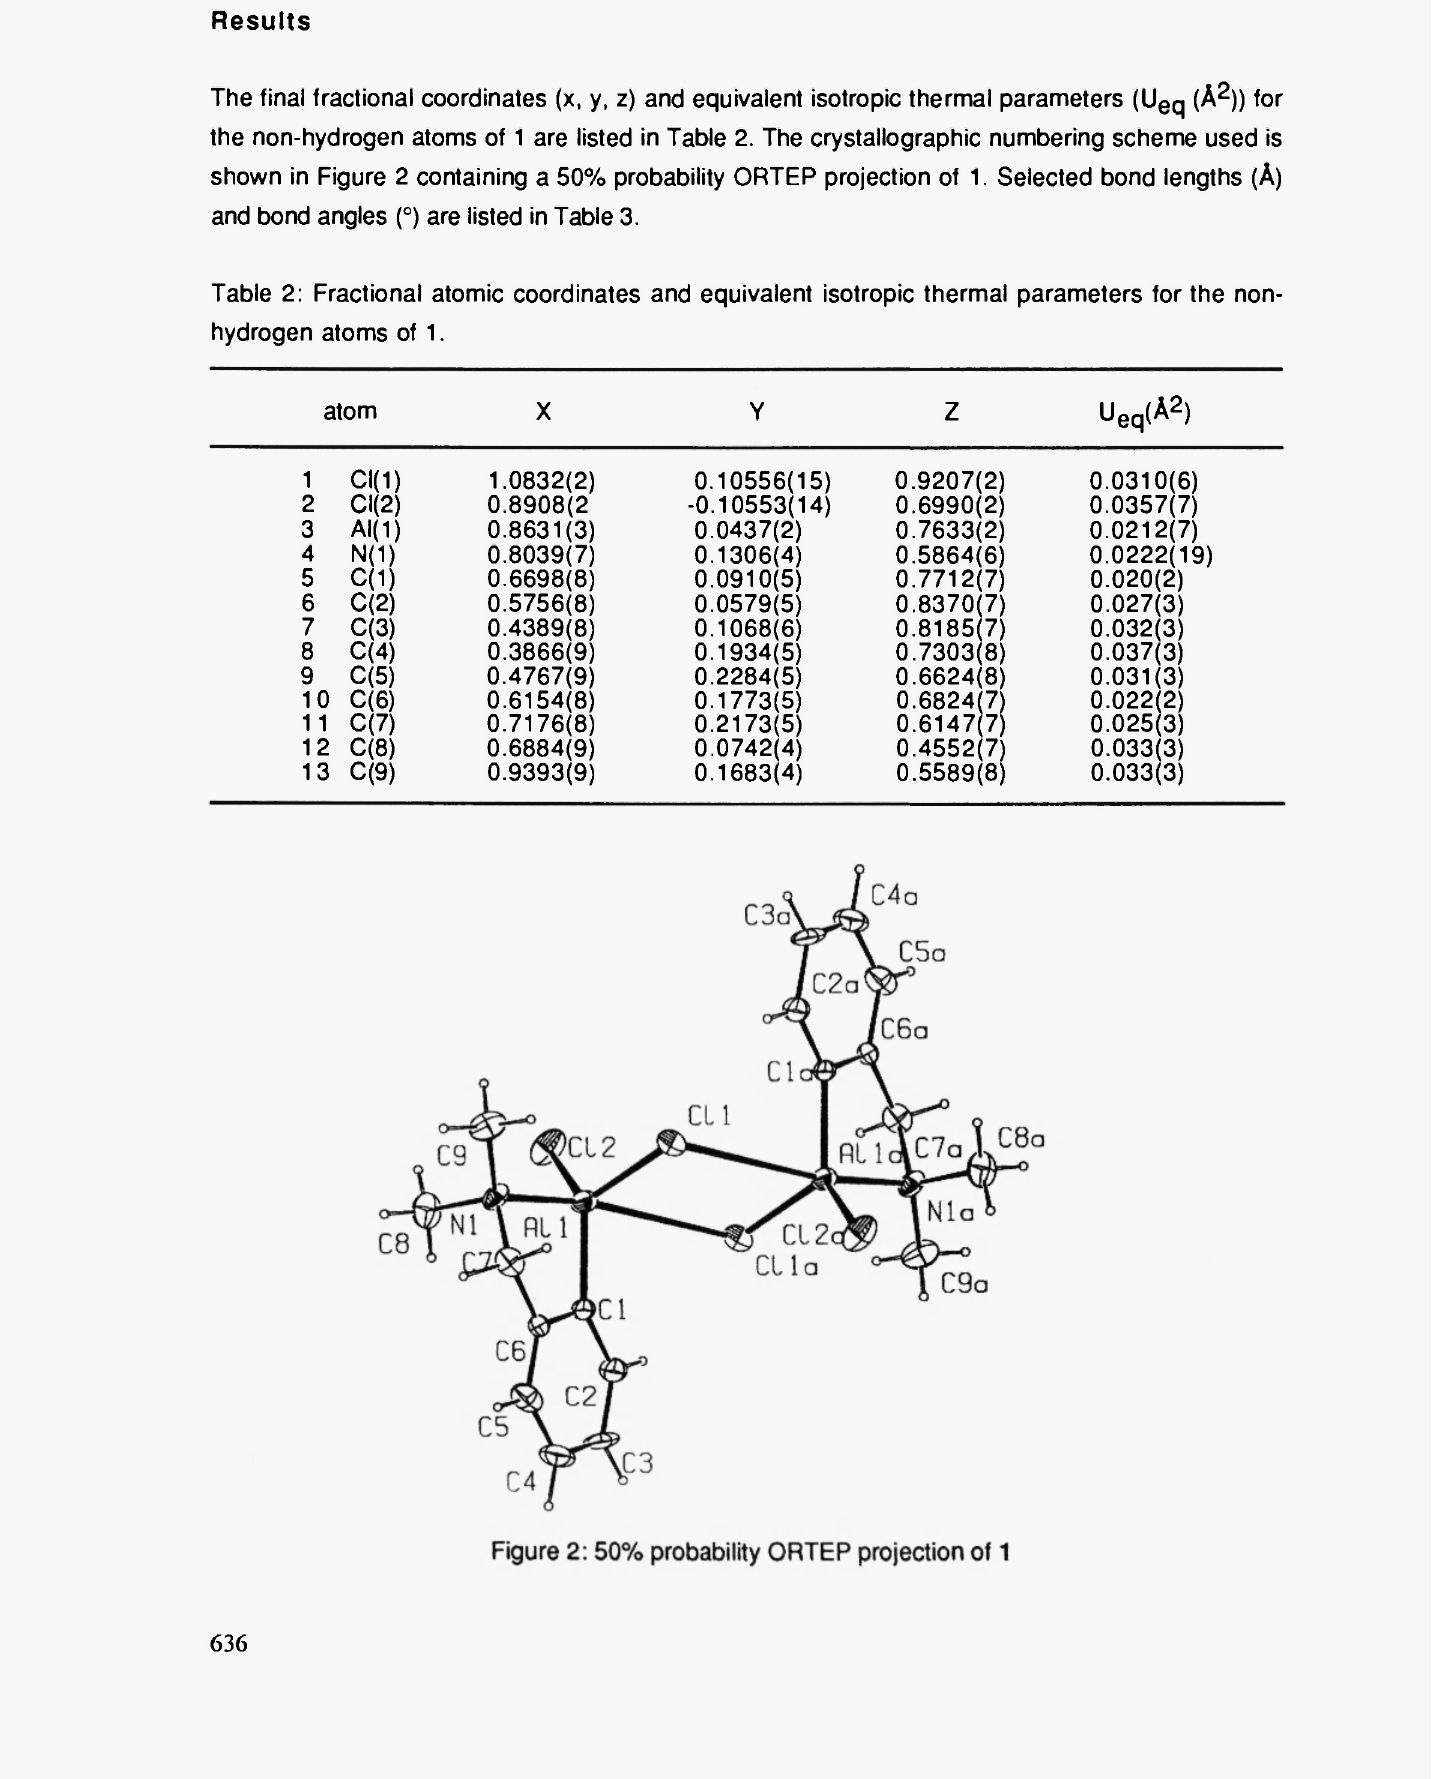
Table 2: Fractional atomic coordinates and equivalent isotropic thermal parameters for the non- hydrogen atoms of